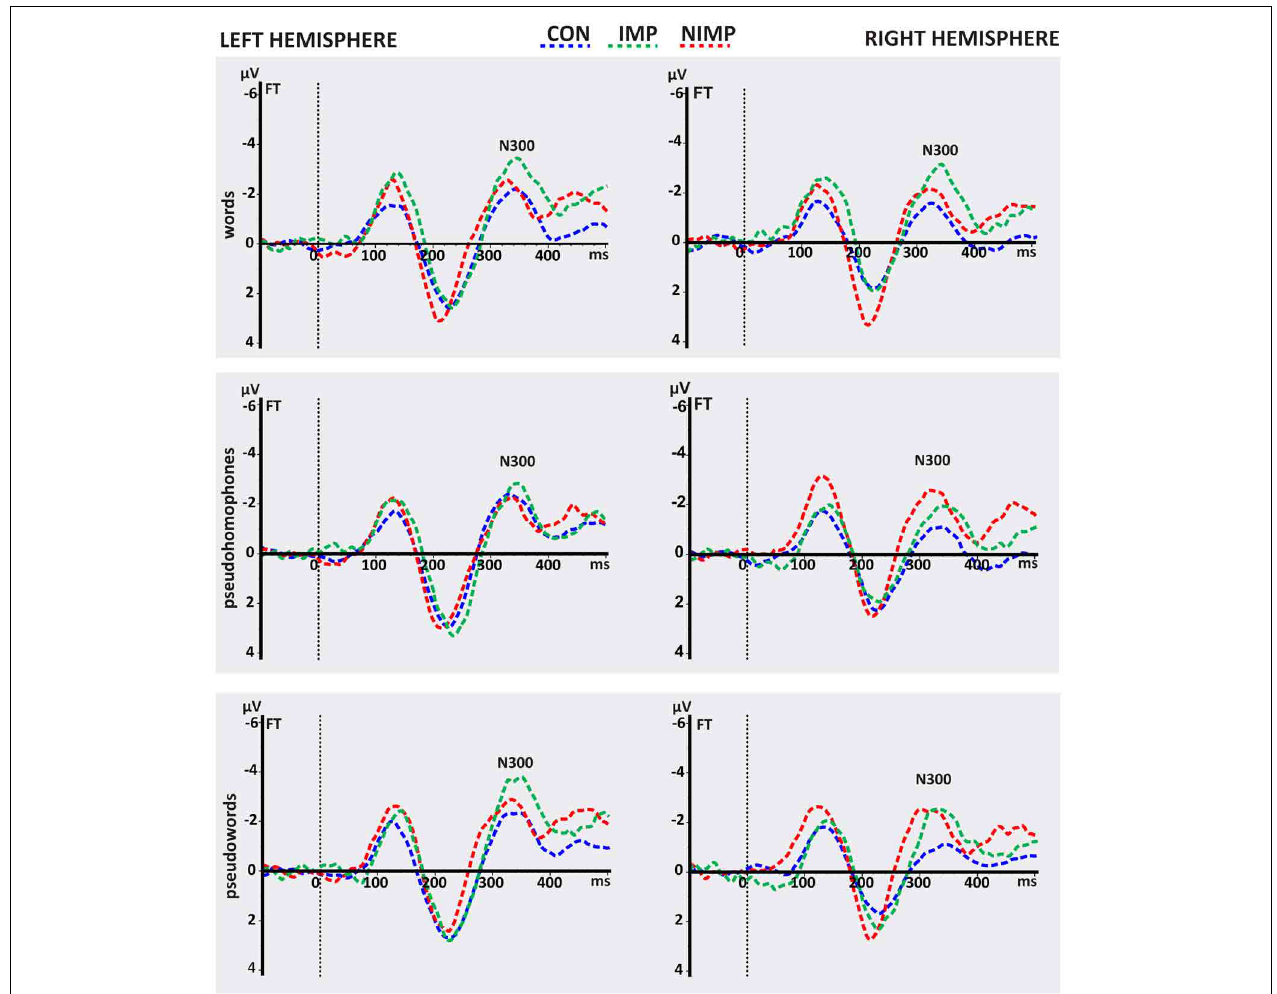
FIGURE 5 | Illustration of the N300 after intervention. FT = fronto-temporal electrodes included in the left hemispheric and right hemispheric ROI of the N300 for control children (CON), improvers (IMP), and non-improvers (NIMP). Negativity is depicted